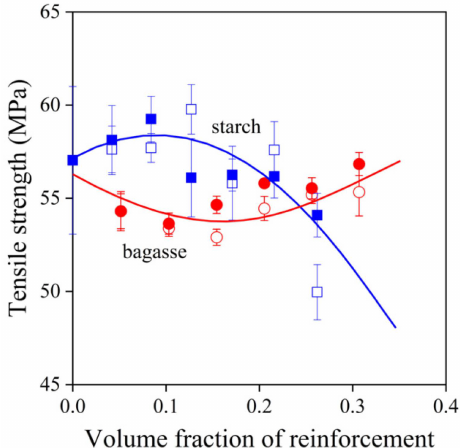
Figure 3. Effect of composition and coupling on the tensile strength of PLA composites. Symbols: Figure 2. Composition dependence of the stiffness of PLA composites reinforced with starch or ba- Figure 2. Composition dependence of the stiffness of PLA composites reinforced with starch or ba- Figure 2. Composition dependence of the stiffness of PLA composites reinforced with starch or ba- Figure 2. Composition dependence of the stiffness of PLA composites reinforced with starch or ba- ) starch; empty symbols without MAPLA, full symbols gasse fibers. Effect of coupling. Symbols: (  ,  ) sugarcane bagasse fibers, (  ,  ) starch; empty gasse fibers. Effect of coupling. Symbols: (  ,  ) sugarcane bagasse fibers, (  ,  ) starch; empty gasse fibers. Effect of coupling. Symbols: (  ,  ) sugarcane bagasse fibers, (  ,  ) starch; empty gasse fibers. Effect of coupling. Symbols: (  ,  ) sugarcane bagasse fibers, (  ,  ) starch; empty symbols without MAPLA, full symbols with MAPLA. symbols without MAPLA, full symbols with MAPLA. symbols without MAPLA, full symbols with MAPLA. symbols without MAPLA, full symbols with MAPLA. with